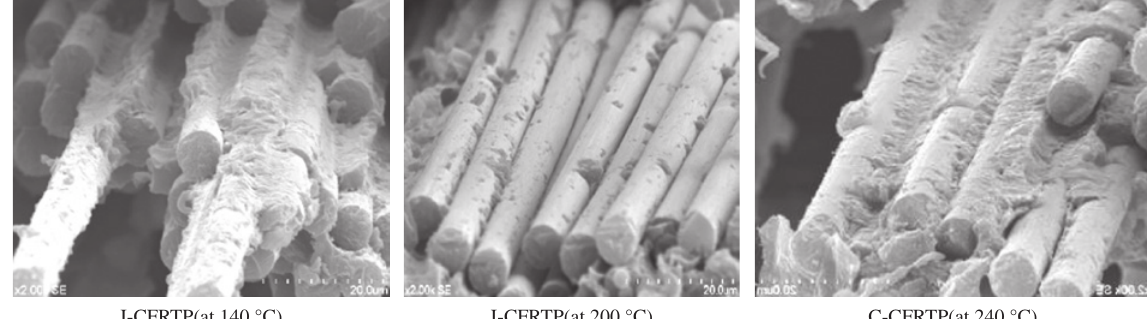
Figure 16 SEM observation of